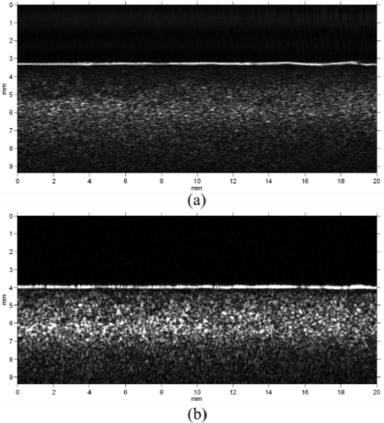
Figure 13. The images of tissue ‐ mimicking phantom ( a ) short pulse and ( b ) chirp ‐ coded excitation.